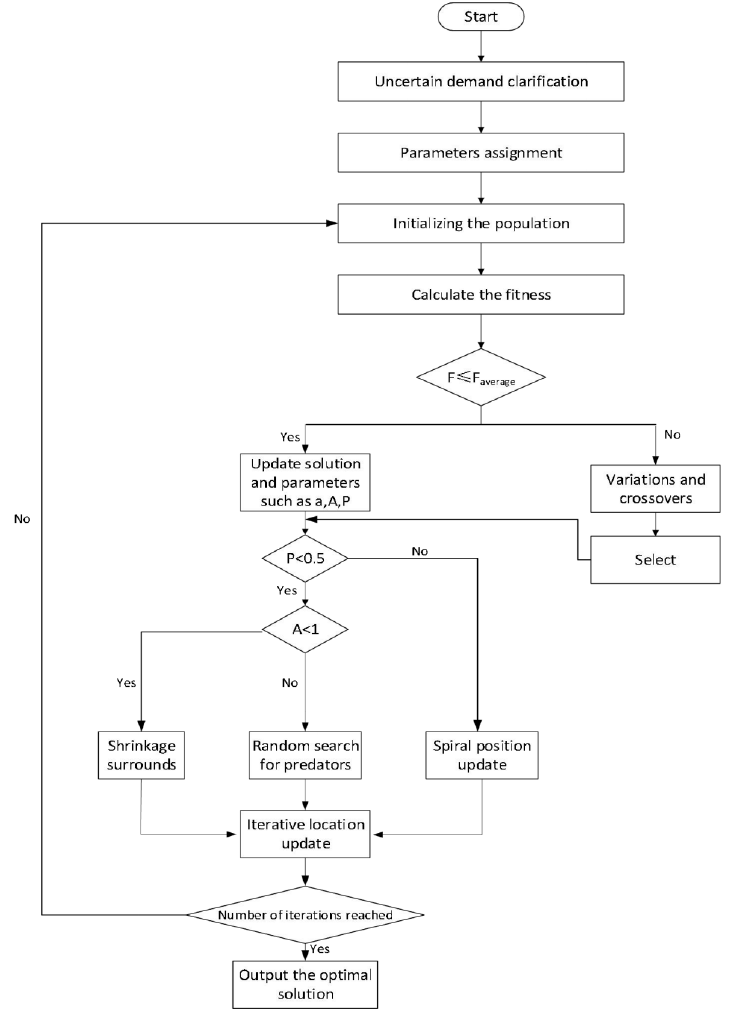
Figure 1. Flowchart of the DE-WOA